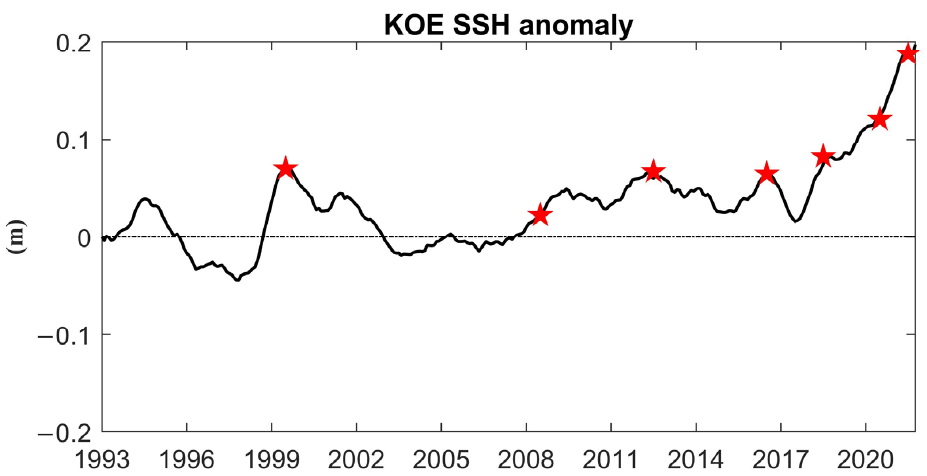
Figure 7. ( a ) The JFM averaged SSH anomalies (shading) and surface geostrophic current anomalies (vectors; showing values greater than 0.05 m s − 1 ) for the KOE summer MHW years. The area framed by the black lines represents the KOE domain. ( b ) Time-depth plots of temperature anomalies (shading) and the MLD (black lines) averaged in the KOE region. The SSH and geostrophic current data are from CMEMS, and the temperature and MLD data are from GODAS.